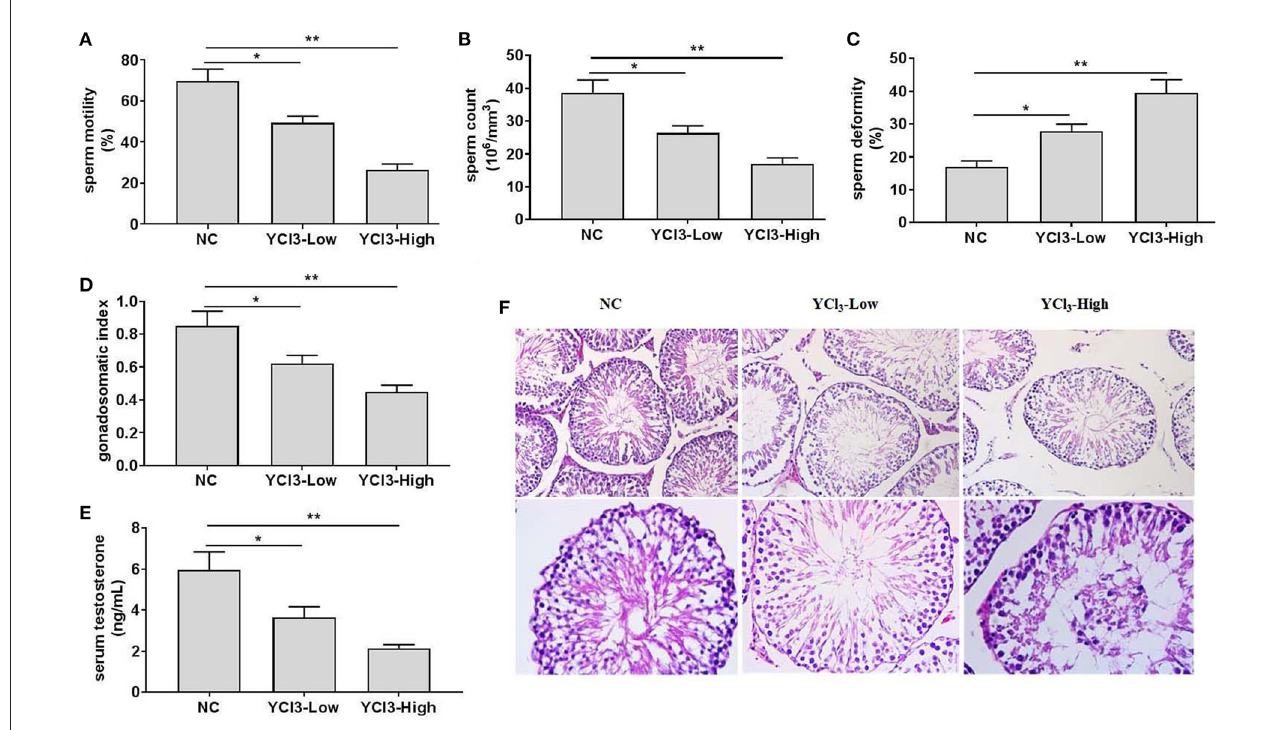
FIGURE1 The effects of chronic exposure to YCl 3 on the rat testis ( n = 10) were investigated. The sperm quality, including sperm motility (A) , sperm count (B) , and sperm deformity (C) was detected. The gonadosomatic index (D) and the serum testosterone level (E) were measured. The histopathological examination (F) of testicular tissues [magnification × 200 (up) and × 400 (down)] by HE staining was conducted. * P < 0.05, ** P < 0.01. NC, negative control; YCl 3 -Low, 12 mmol/L YCl 3 ; YCl 3 -High, 24 mmol/L YCl 3